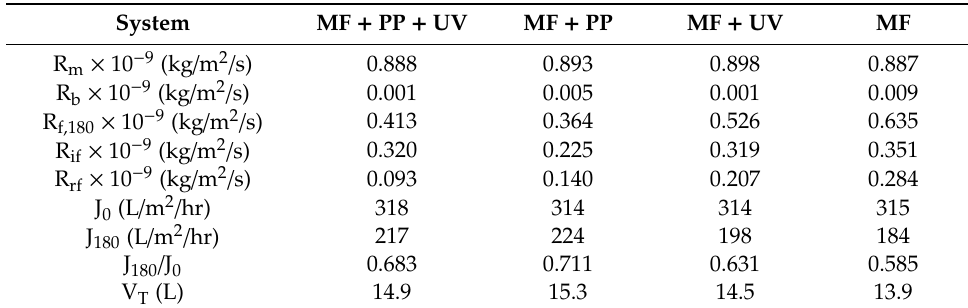
Figure 2. Function of microfiltration, adsorption of PP particles, and photo-oxidation of UV radiation in the integrated system of multichannel ceramic MF and PP particles using periodic air backwashing: ( a ) Membrane fouling resistance and ( b ) dimensionless treated flux. Table 2. Function of microfiltration, PP particles adsorption, and UV radiation photo-oxidation on separation elements in the integrated system, of multichannel ceramic MF and pure PP particles, using periodic air backwashing at HA 6 mg/L.